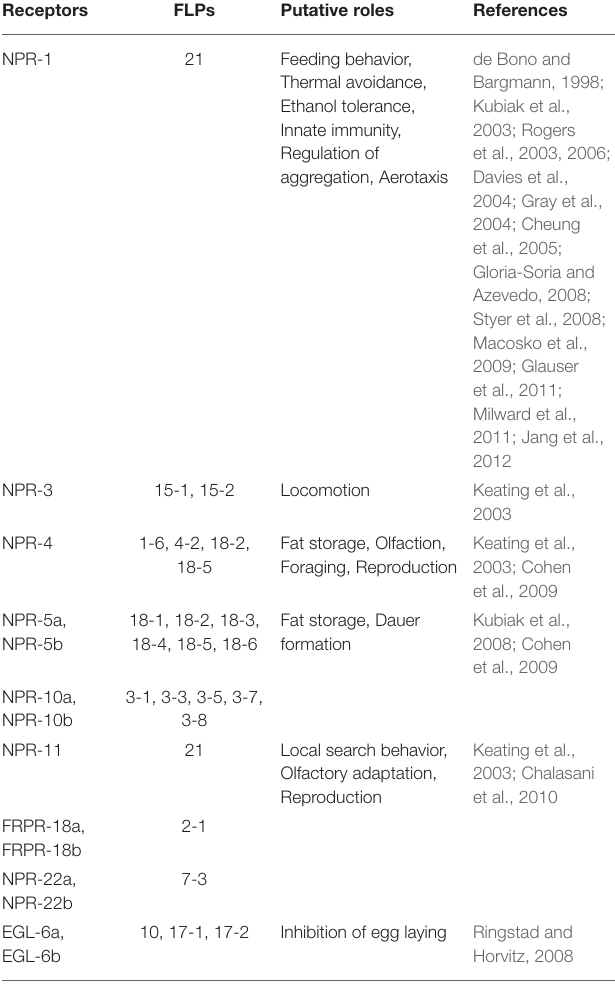
TABLE 3 | Deorphanized C. elegans FLP receptors and their putative roles.